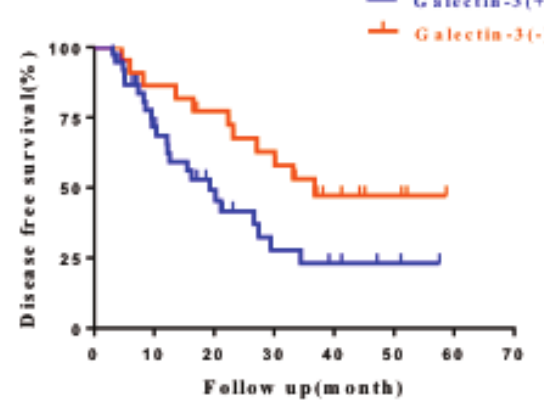
Figure 2: The disease survival curve comparison between galectin-3 positive and negative